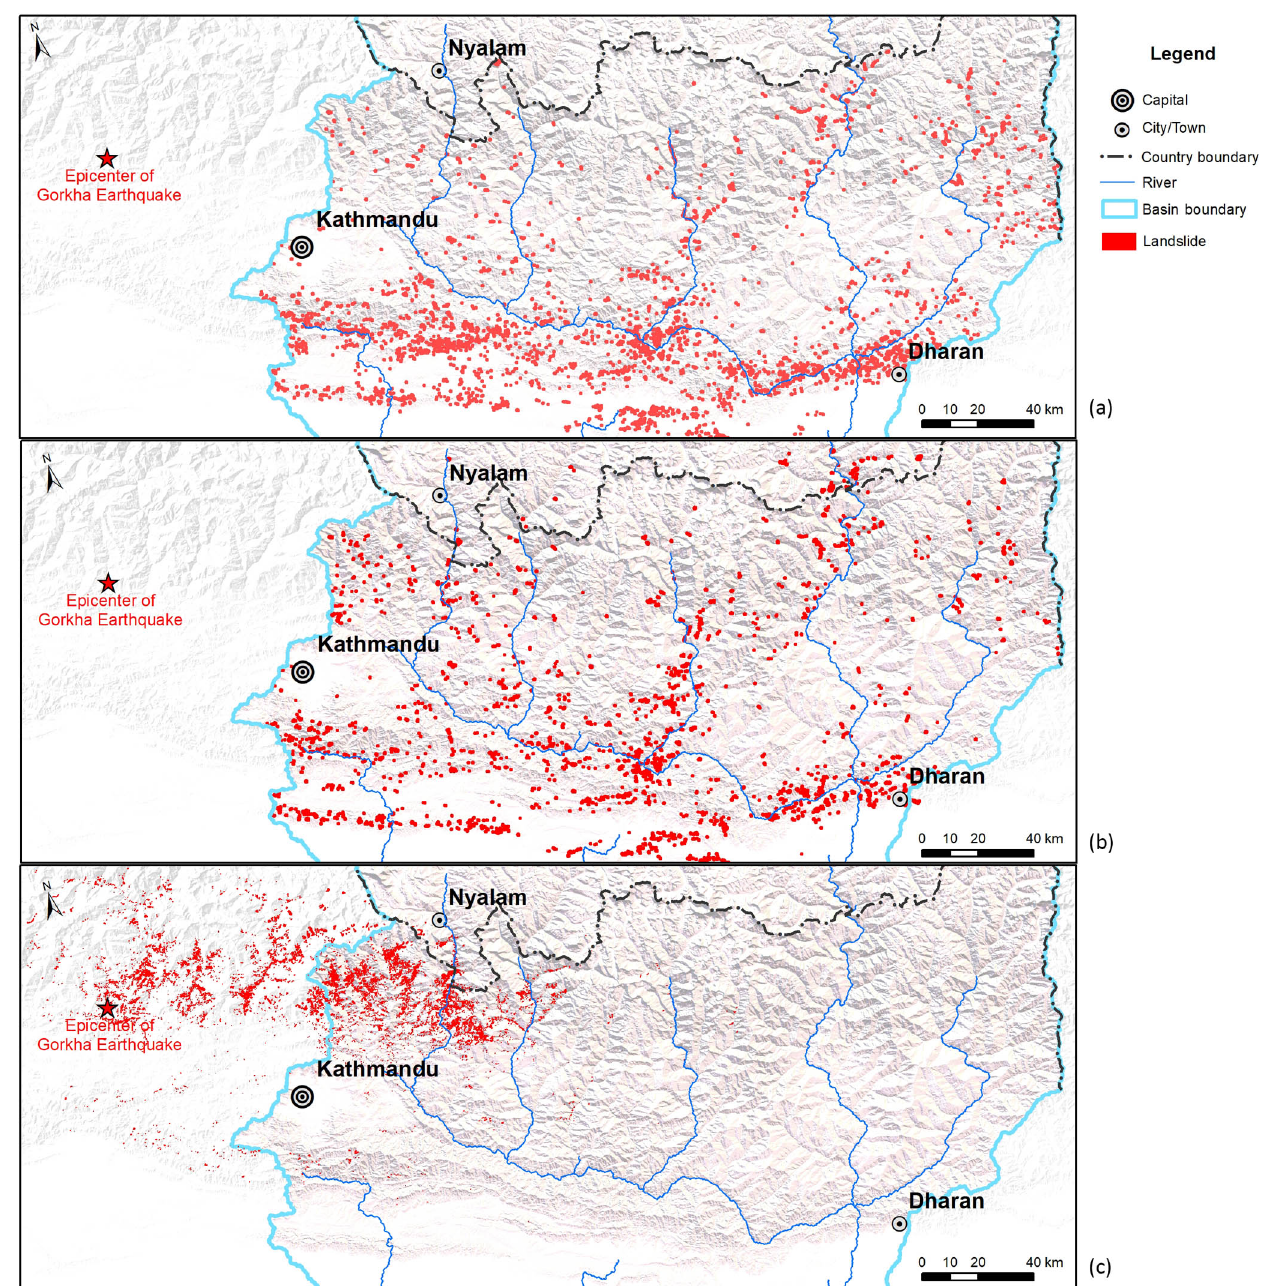
Figure 4. Landslide inventories of the Koshi River basin. (a) Rainfall-induced landslide inventory of events before 1992. (b) Rainfall-induced landslide inventory for the period between 1992 and 2015. (c) Inventory of landslides triggered by the 2015 Gorkha earthquake (Roback et al.,